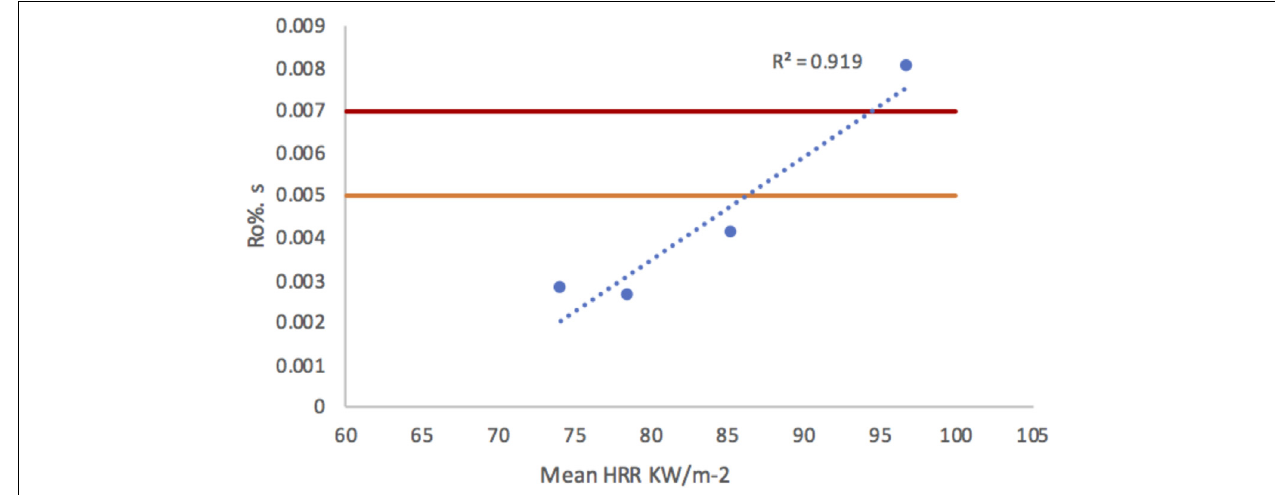
FIGURE 11 | Graph of mean heat release and standardized charcoal reflectance as a function of time (Ro%.s) indicating a strong positive correlation.